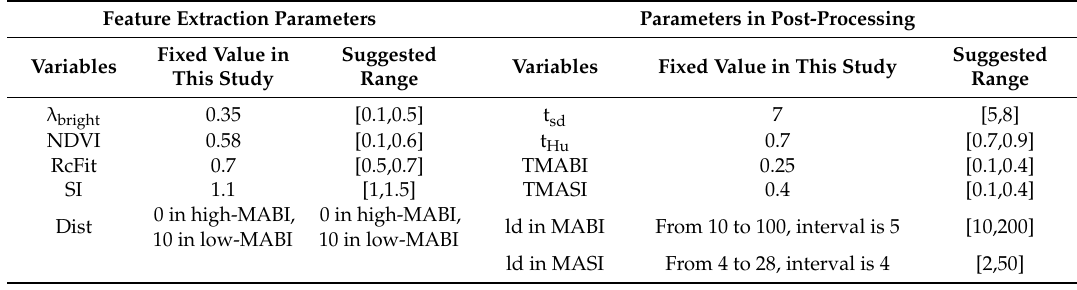
Table 4. Parameters and the suggested range of the proposed method.